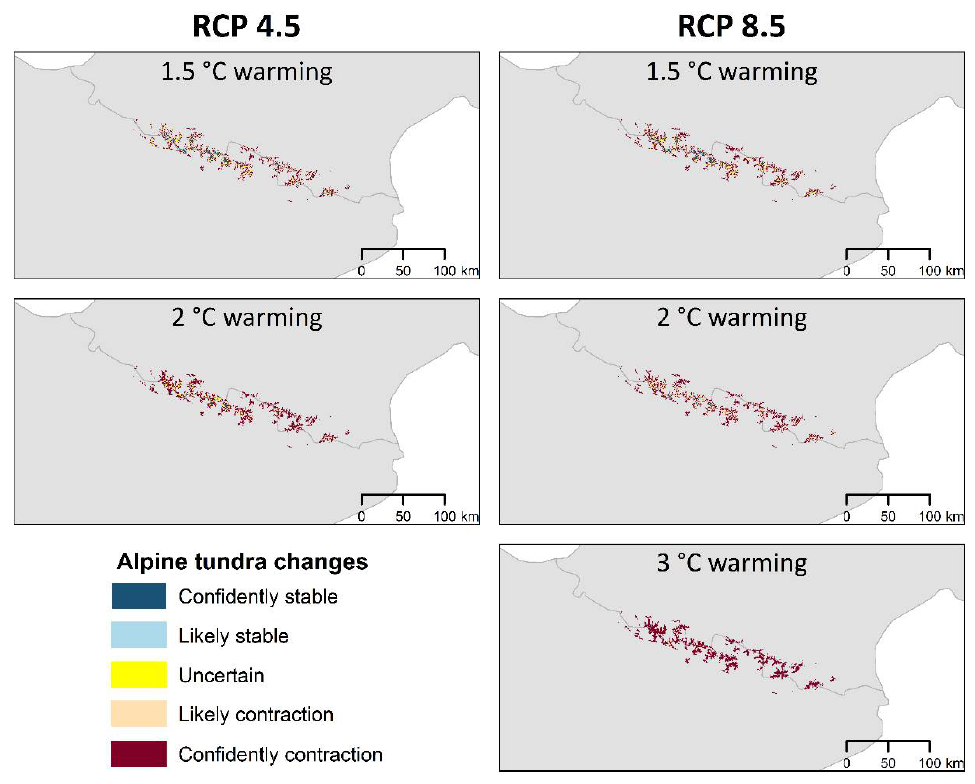
Figure 7. As for Figure 5 but for the Pyrenees.